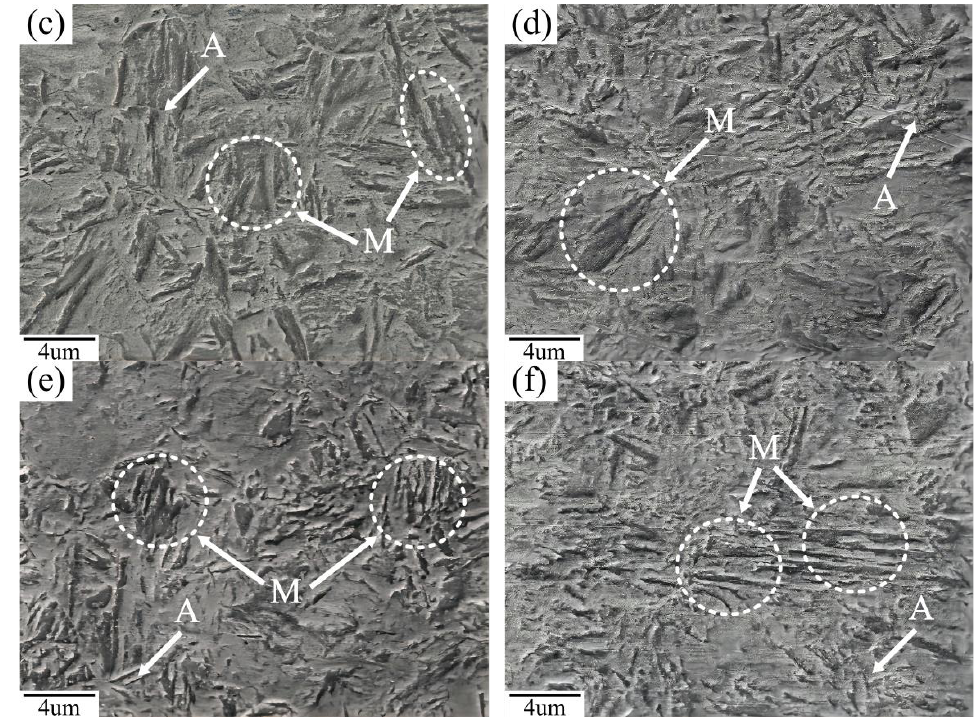
Figure 9. SEM image of processed surface. ( a ) control group T0; ( b ) group T1; ( c ) group T2; ( d ) group T3; ( e ) group T4; ( f ) group T5.